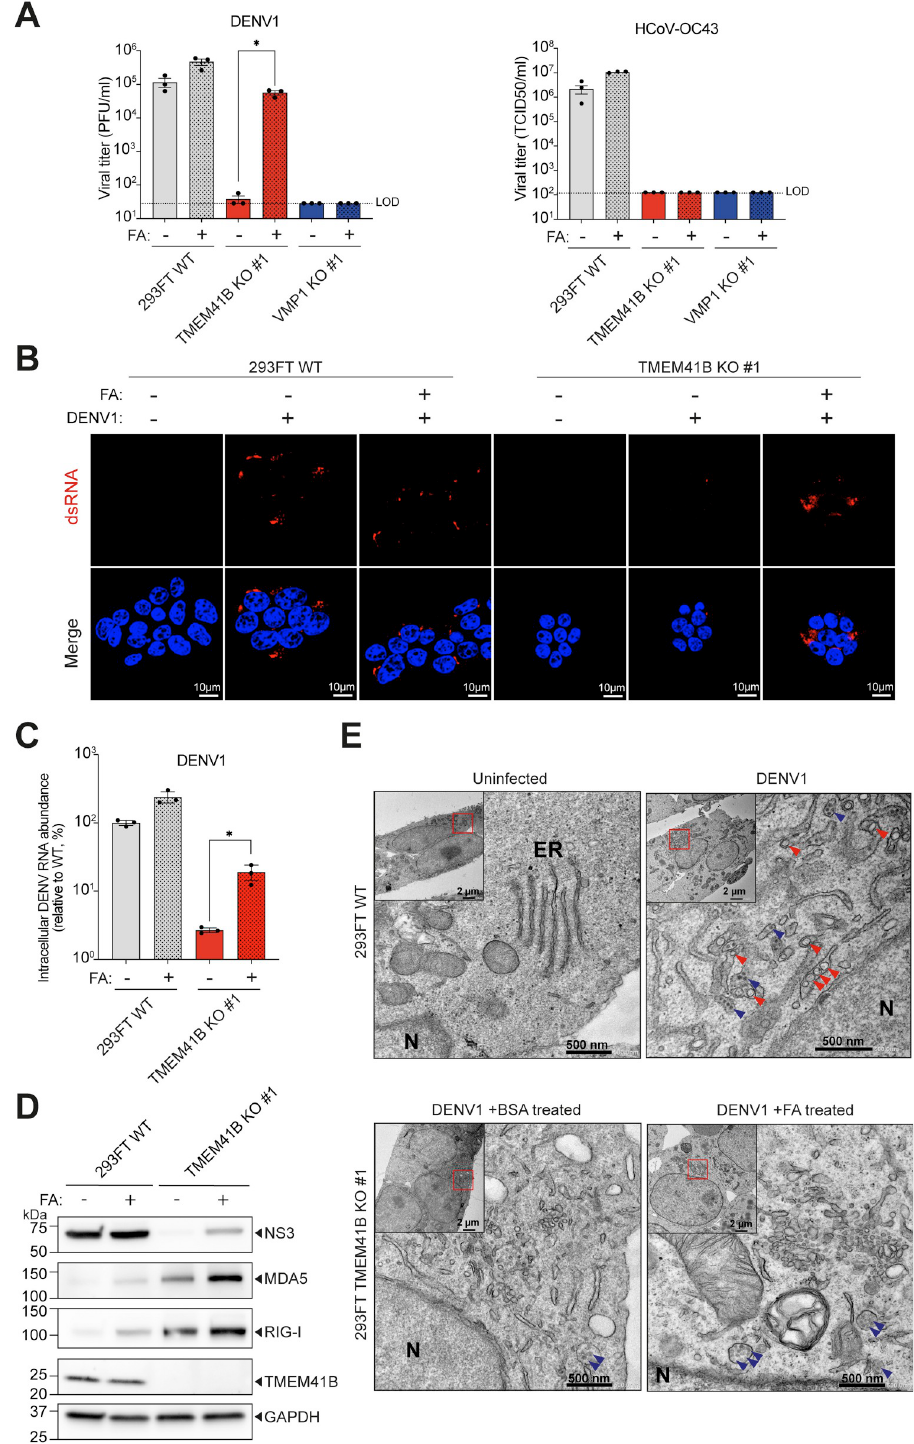
Fig 3. Exogenous fatty acid complementation can partially rescue DENV infection in 293FT TMEM41B KO cells but not VMP1. (A) Infectious viral particles produced in 293FT WT, TMEM41B KO clone #1, and VMP1 KO clone #1 cells upon FA supplementation. DENV1 infection was carried out at MOI of 1 and progeny viruses were harvested at 72 hours post-infection. HCoV-OC43 infection was done at MOI of 0.5 and progeny viruses were harvested at 48 hours post-infection. Cells were treated with a 1:1 mixture of oleic and linoleic acid (FA), or BSA. (B) Confocal